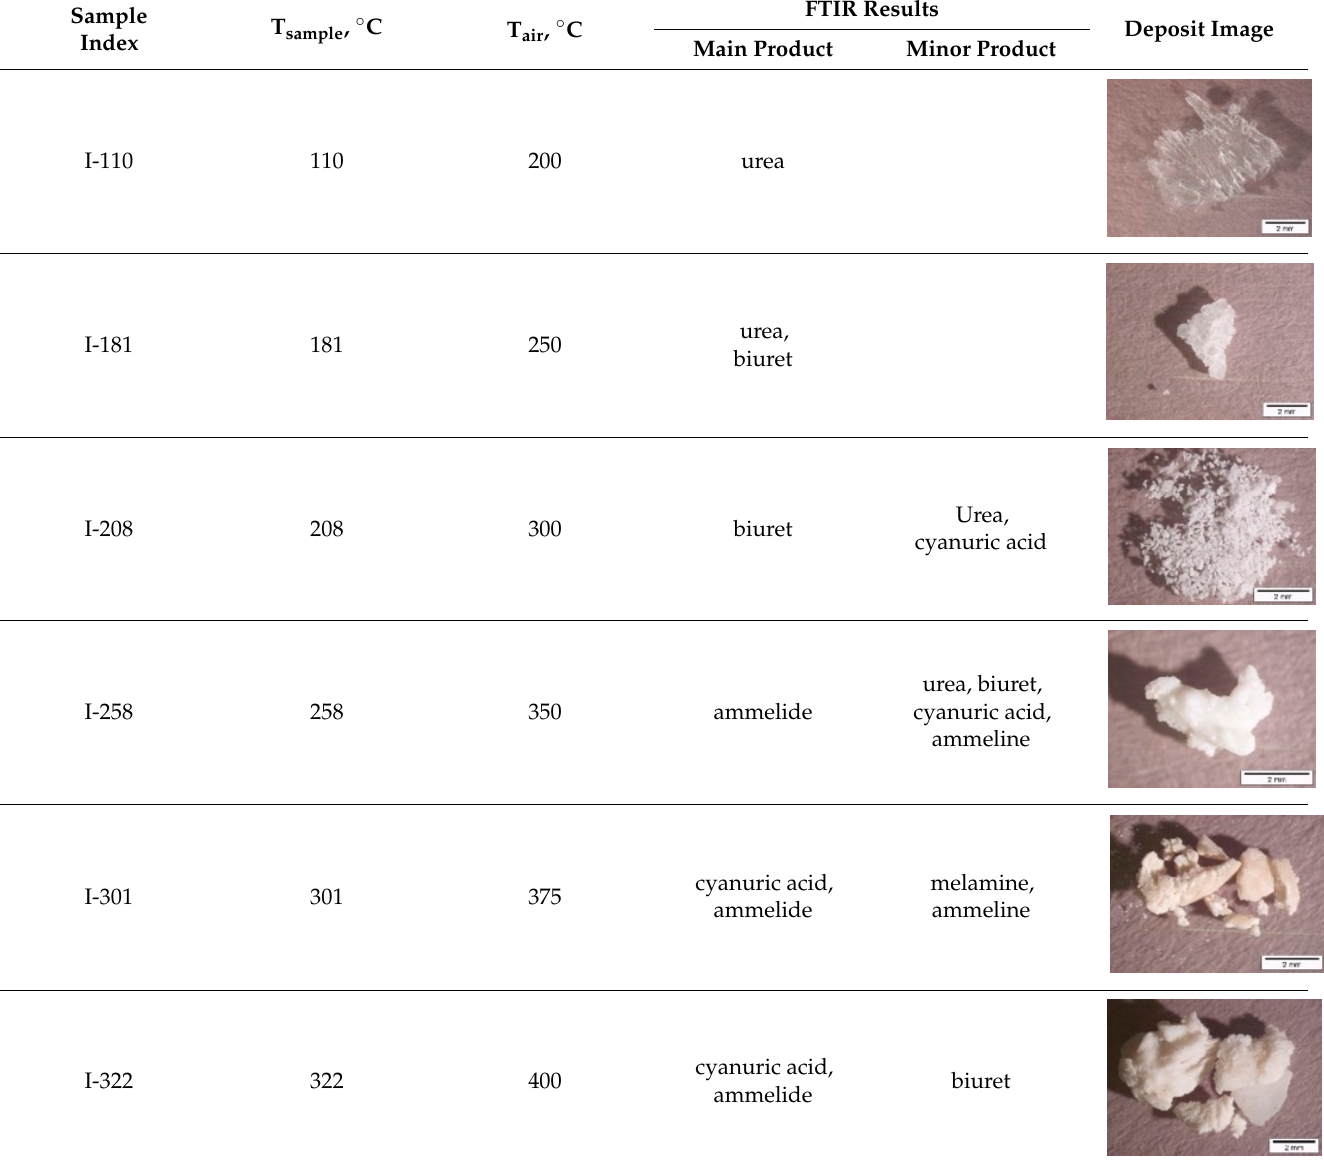
Table 3. Characterisation of deposit samples from the isothermal experiment.